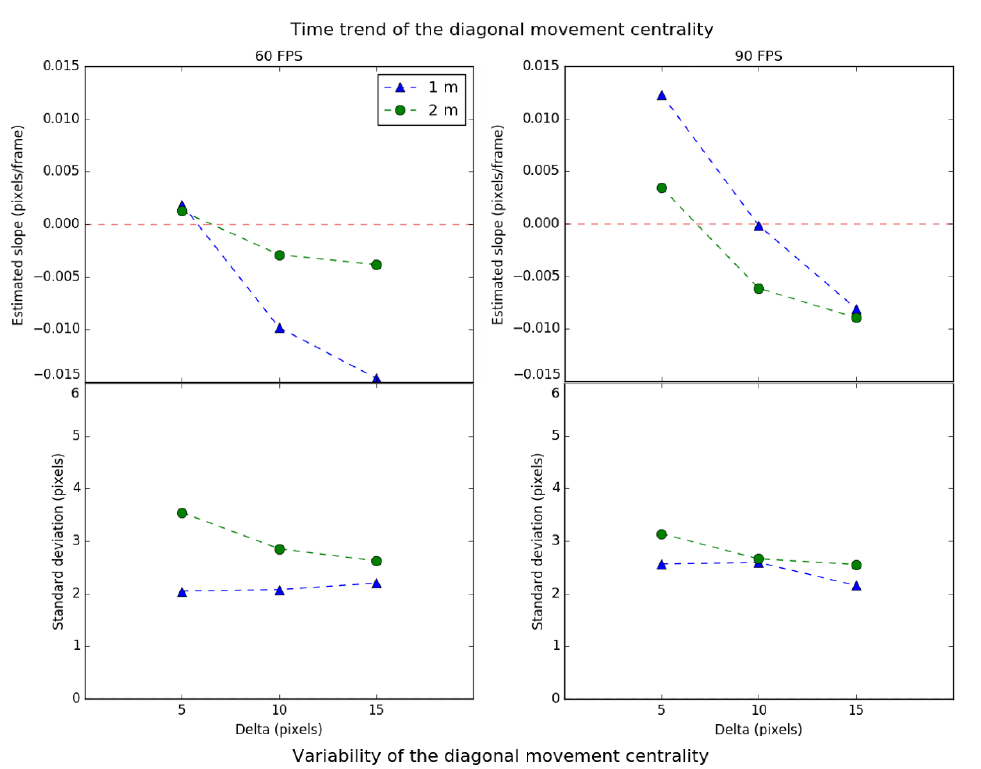
Figure 12. Time trend and variability of the centrality for diagonal movement.